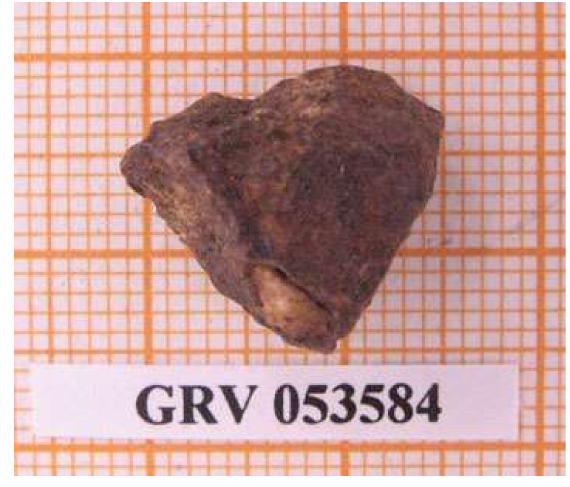
Figure 1. An overview of the chondrite GRV053584. Each thick line grid is 1